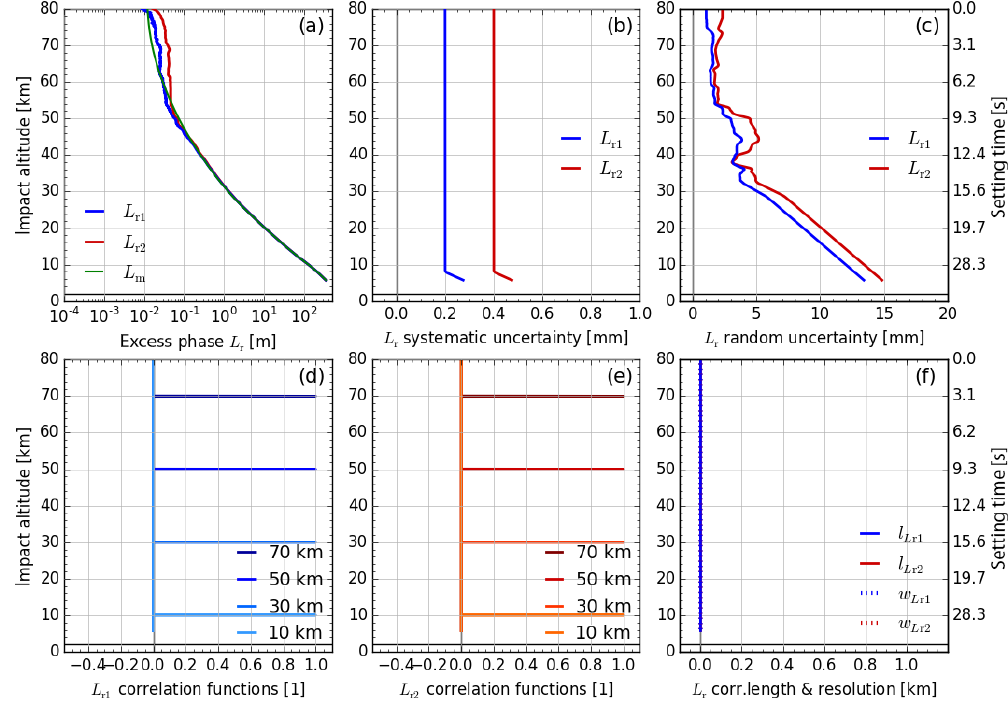
Figure 3. Input profiles of retrieved excess phase L r (with model profile L m for comparison) in panel (a) , estimated systematic uncertainty profiles u s in panel (b) , estimated random uncertainty profiles u r in panel (c) , representative correlation functions R L r ,i (at 10, 30, 50, and L r L r 70km) in panels (d) and (e) , and correlation length l L r (solid) and resolution profiles w L r (dotted) in panel (f) , which are set zero for these initial essentially uncorrelated input data. All profiles are shown for both GPS carrier frequencies: f T1 (blue) and f T2 (red).